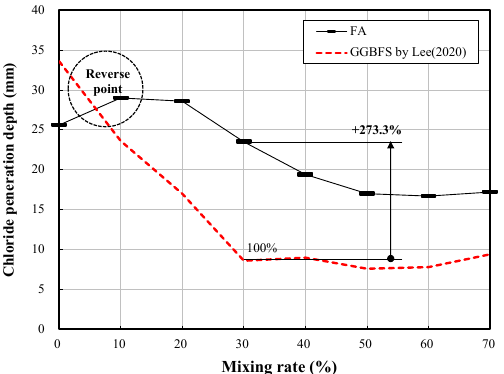
Figure 12. Results of the chloride penetration depth of OPC and FA compared with GGBFS as measured by Lee (adapted from [26]) in terms of the mixing rate.